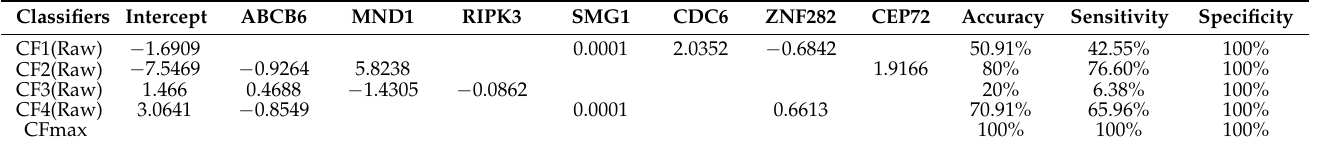
Table 20. Performance of individual classifiers and combined max-competing classifiers using blood- sampled data GSE201530 to classify the COVID-19 infected and healthy controls into their respective groups. The meaning of CF-i is the same as those in Table 1. Raw stands for raw